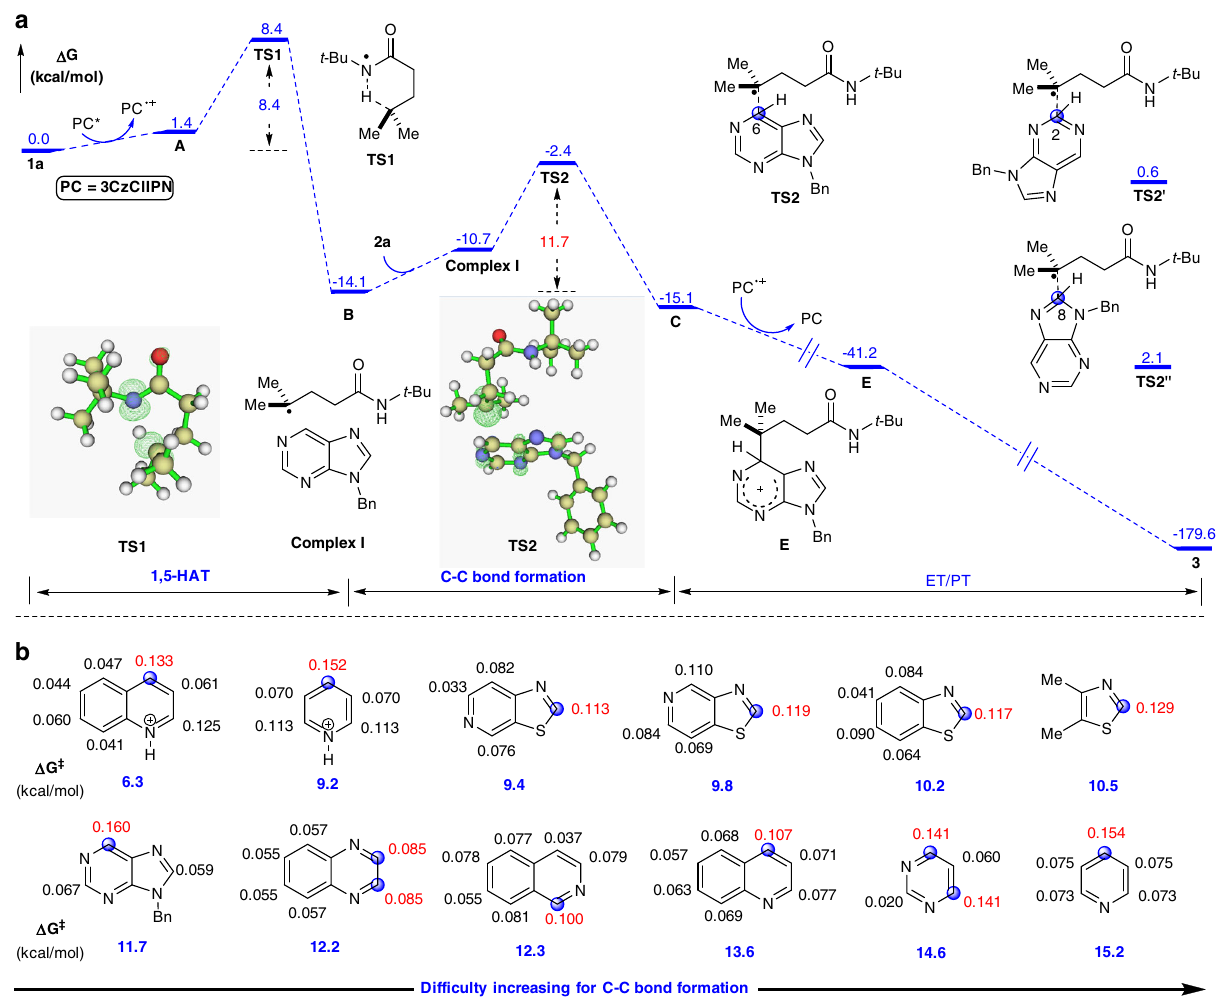
Fig. 3 Density functional theory calculations. a Computed Gibbs free energy pro fi le for the redox-neutral coupling reaction of 1a and 2a catalyzed by photocatalyst 3CzClIPN and spin density of transition states TS1 and TS2 . Energies are given in kcal mol − 1 . b Fukui indices and free energy barriers for the C – C formation steps at each position predicted by Fukui indices ( f + ) (Highlighted in blue